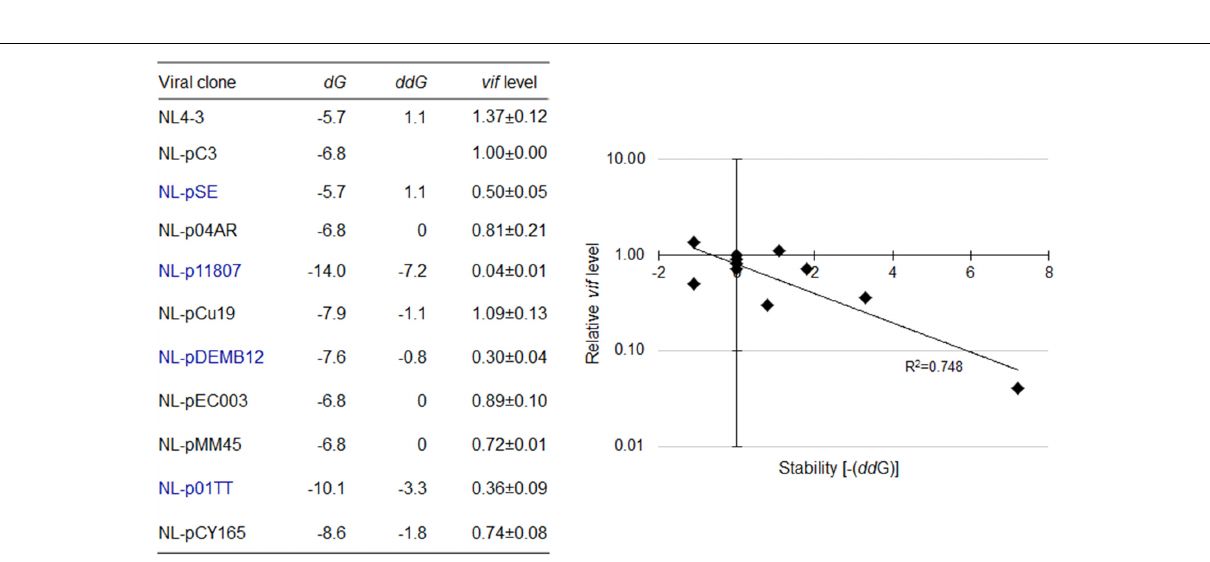
Frontiers in Microbiology |